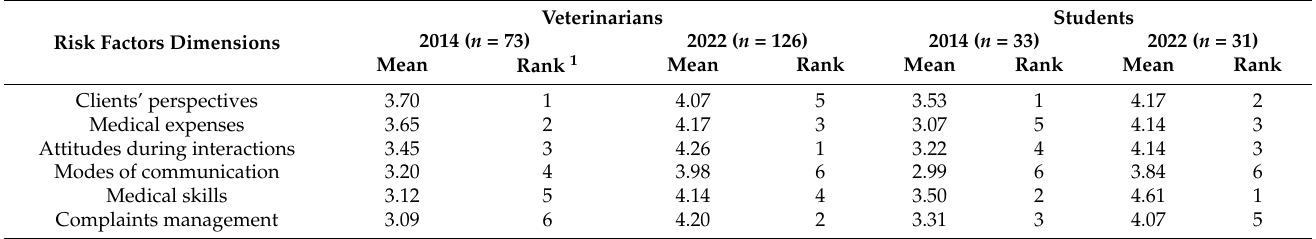
Table 3. Ranking of the perceptions of risk factors in six dimensions for veterinarians and students in 2014 and